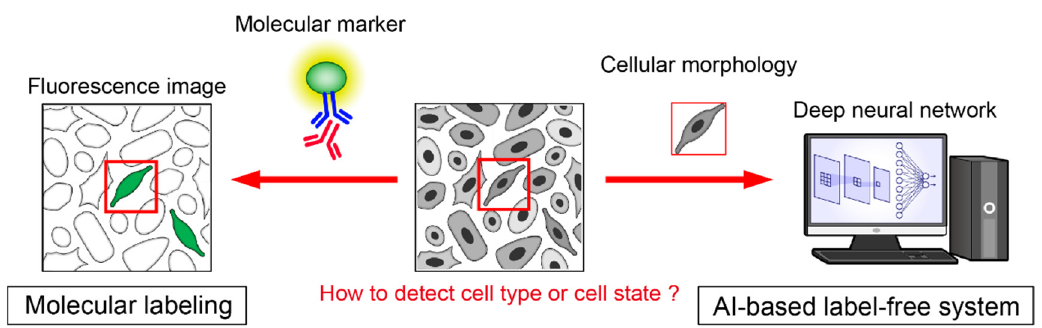
Figure 4. Label-free cell recognition by artificial intelligence.: In the molecular biology-based ap- proach, we labeled the cells with a specific molecular marker to infer the cell type or state before observation (left). On the other hand, in the AI-based approach, AI detects the morphological changes in cells from microscopy images and infers the cell type or state label-free.